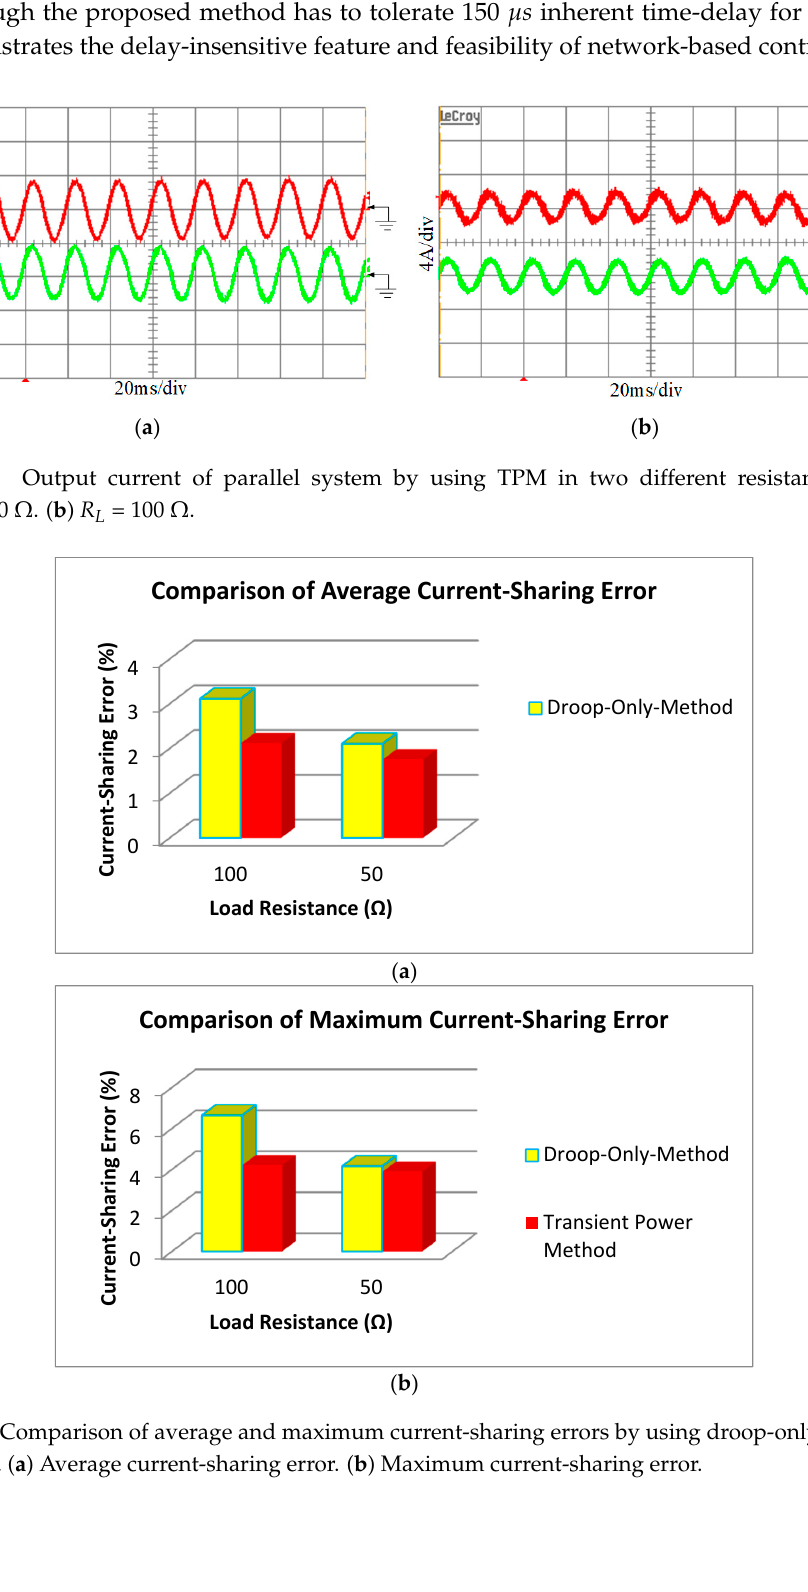
Figure 6. Output current of parallel system by using TPM in two different resistance loads. ( a ) R L = 50 Ω . ( b ) R L = 100 Ω .